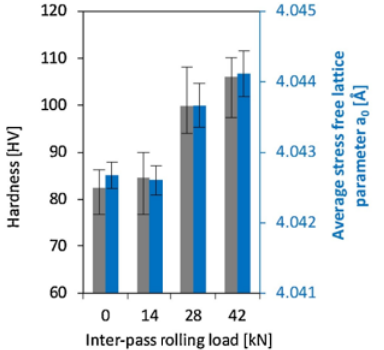
Figure 22. Evolution of hardness with an increment in applied load [94]; with permission from Elsevier.